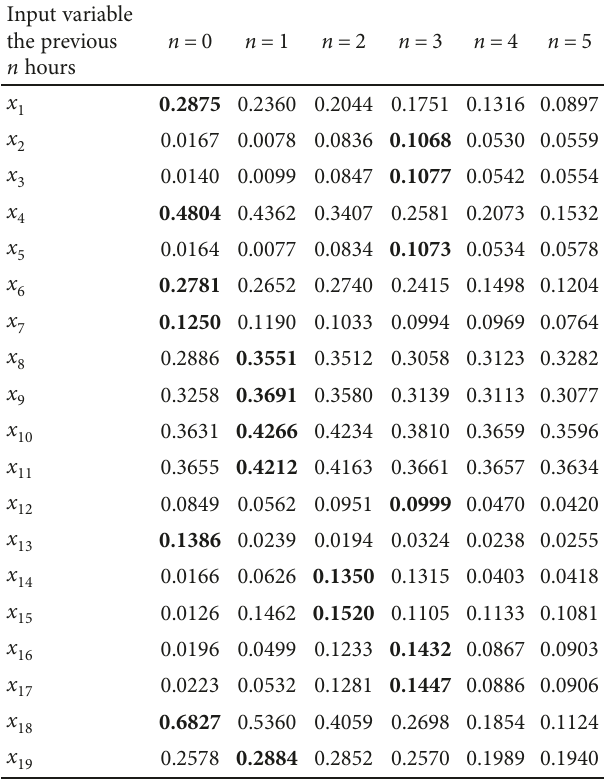
Table 2: Di ff erent time delay correlation coe ffi cients under the input variables and the calculation results of the [Si]%